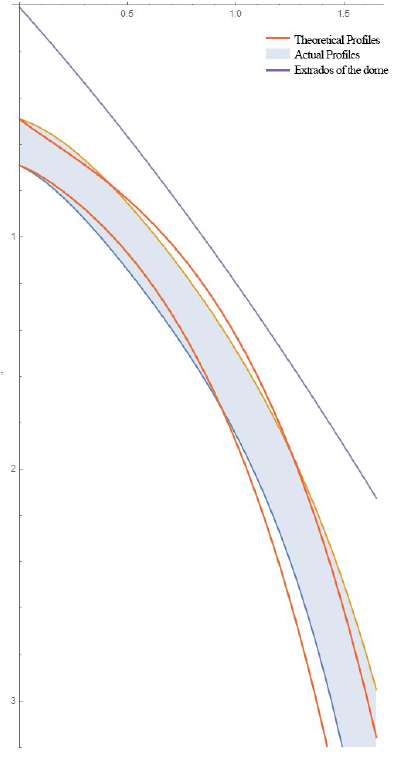
Figure 8: Actual and theoretical profiles of the candela obtained for φ 0 = 41.27 ∘ by NFMCT (that is, considering only the self-weight of the candela)